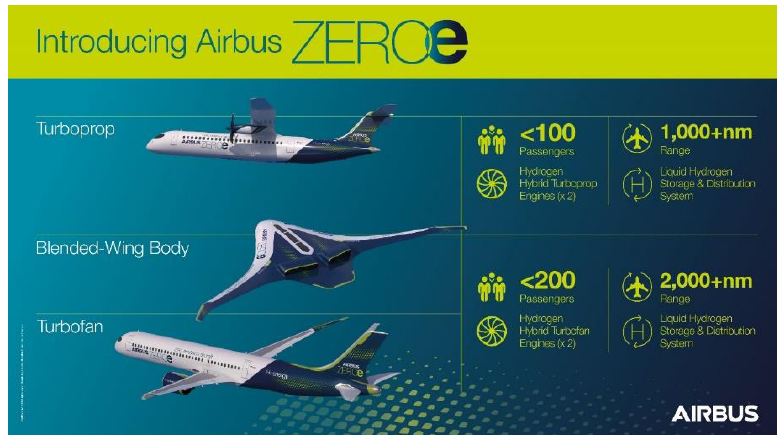
Figure 22. The three aircraft concepts from Airbus using LH 2 as an energy carrier to reduce the environmental footprint of aviation. Aerospace 2020 , 7 , x FOR PEER REVIEW